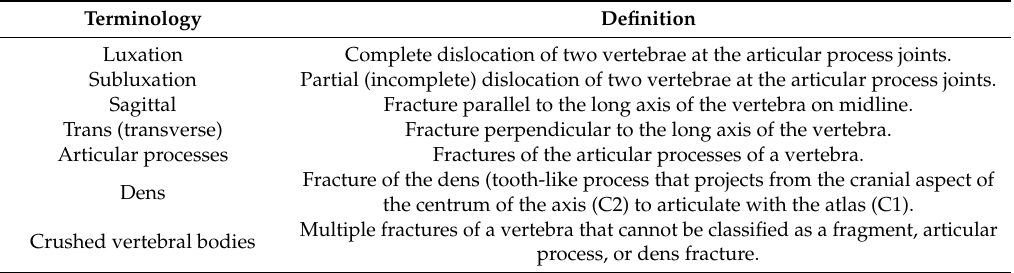
Table 3. Definitions for the terminology used in radiograph evaluation.